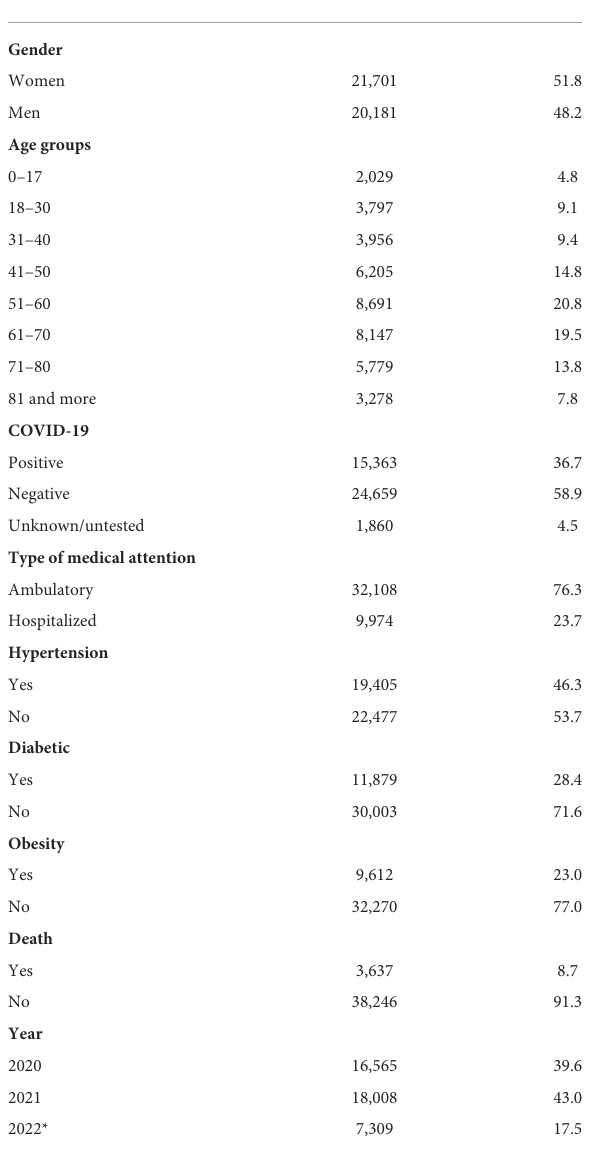
TABLE 1 Profile for patients diagnosed with CVDs ( n =